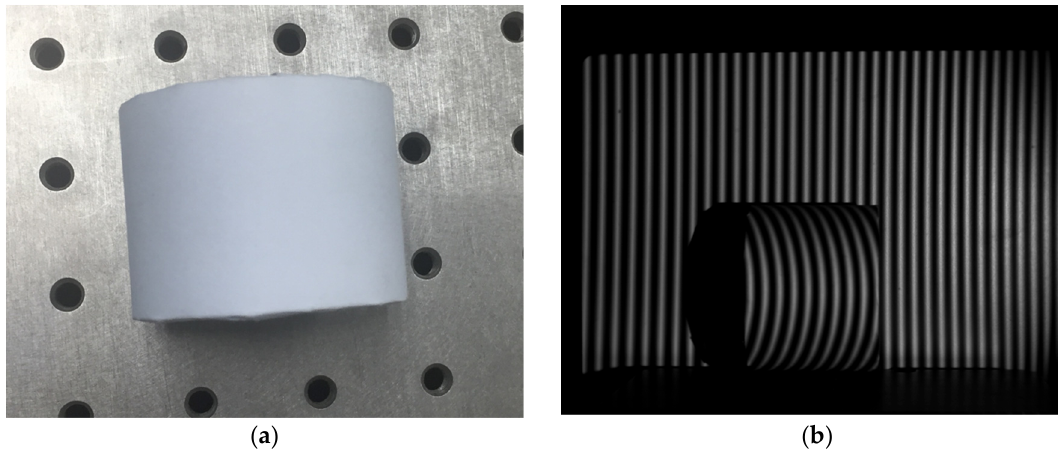
Figure 9. ( a ) Measured cylinder; ( b ) Measured cylinder’s structured light fringe pattern.